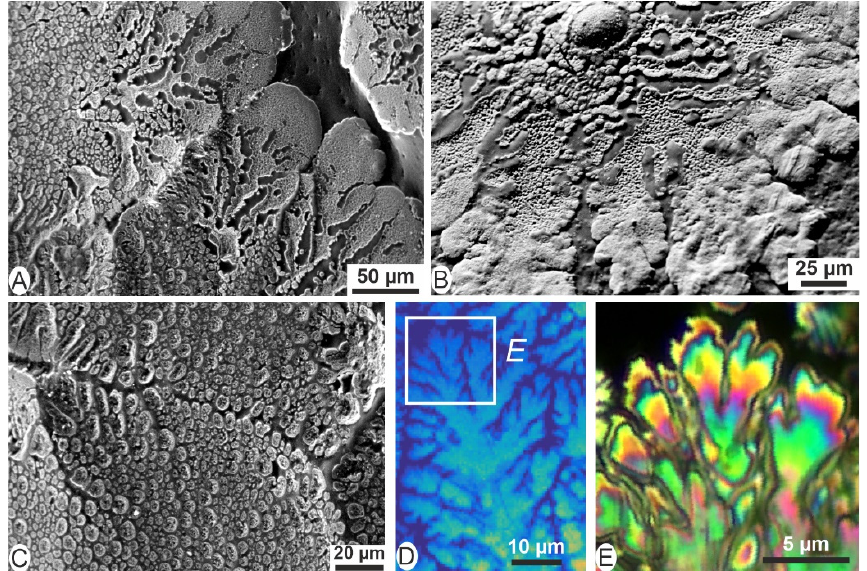
Figure 7. Expanding mucus onto the nucleus surface and its leading role in the first crystallization. ( A , B ) Earliest secretions by the pearl sac appear as expanding mucus radiating from centers. ( C ) The diverging branches comprise tiny particles forming the earliest mineral units. ( D ) Calcium fluo- rescence from the end of an expanding sector. ( E ) Polarized light optical microscopy of the end of this expanding sector provides evidence of the consistency in crystallographic arrangement of the mineral particles.